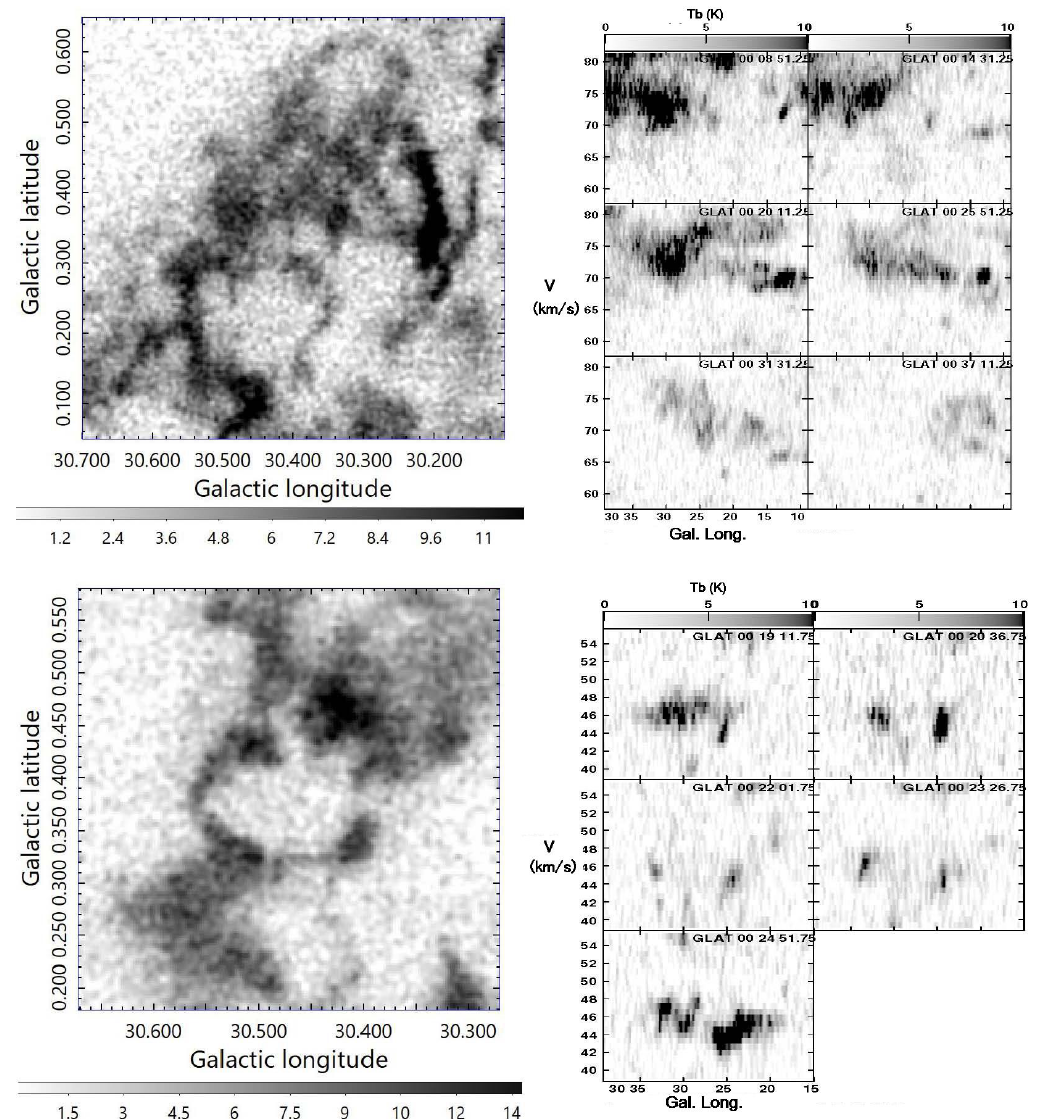
Figure 4. T B maps and longitude-velocity (LV) diagrams of CO bubbles at different velocities in different arms : ( Top ) G30.4+0.4+70 km s − 1 and ( bottom ) G30.45+0.36+46 km s − 1